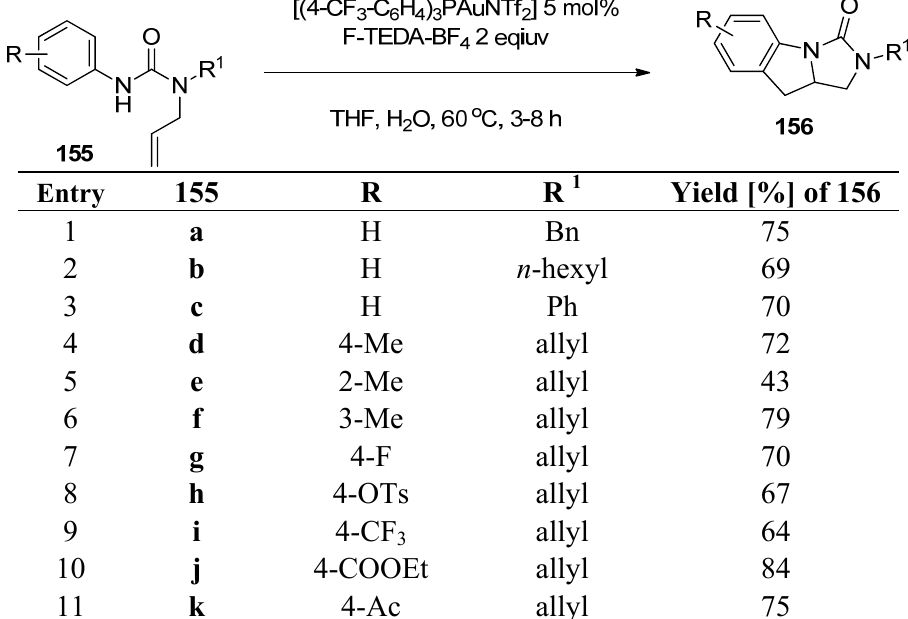
Table 16. Gold-catalyzed and F-TEDA-BF